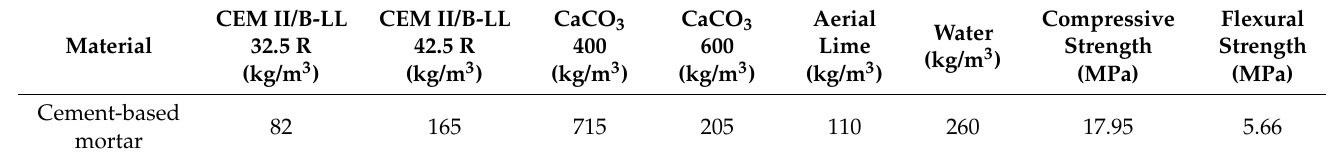
Table 1. Mix proportions and mechanical properties of the inorganic matrix.